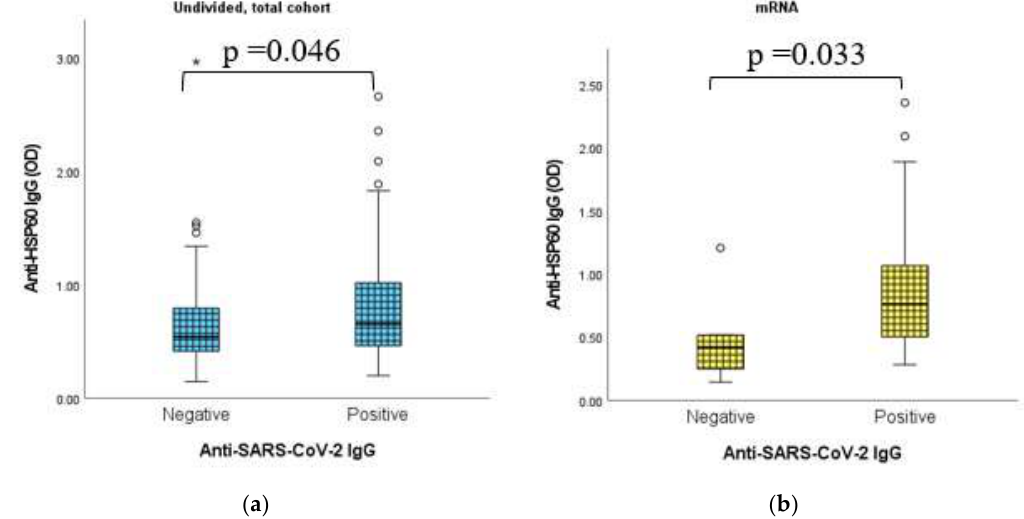
Figure 9. ( a ) Connection between anti-HSP60 IgG titers and anti-SARS-CoV-2 IgG results in the un- divided, total sample cohort. ( b ) Connection between anti-HSP60 IgG titers and anti-SARS-CoV-2 IgG results in the mRNA vaccine group. Anti-SARS-CoV-2 IgG qualitative (positive and negative) results were evaluated as per the manufacturer’s instructions. Anti-HSP60 IgG absorbance (OD) results were handled as continuous, non-normally distributed integers and the alterations of titers were considered. The sample numbers were as follows: ( a ) undivided total cohort, anti-SARS-CoV-2 IgG negative/positive = 48/136 and ( b ) mRNA vaccine group, anti-SARS-CoV-2 IgG negative/pos- itive = 6/63. Total = 185.